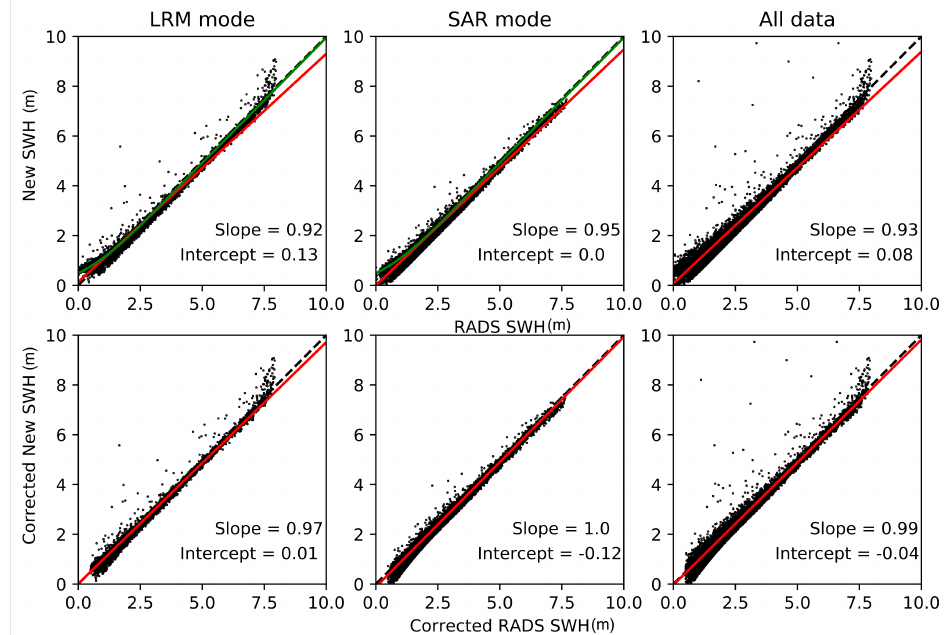
Figure 8. Detailed comparisons between our new SWH and the RADS product for data in 2014. Data has been collected onto a 100 km grid before comparison. Locations where RADS data are 0.5 m greater than our new data are omitted. The top row is for the raw data product, equivalent to that shown in Figure 5, the second row shows comparisons between the corrected RADS data and our new SWH with the mode bias removed. The columns separate between data collected in LRM and SAR mode. The green line in the top left panel represents the correction applied to the RADS data by [17]. The red lines are the linear best fit between our new data and the RADS